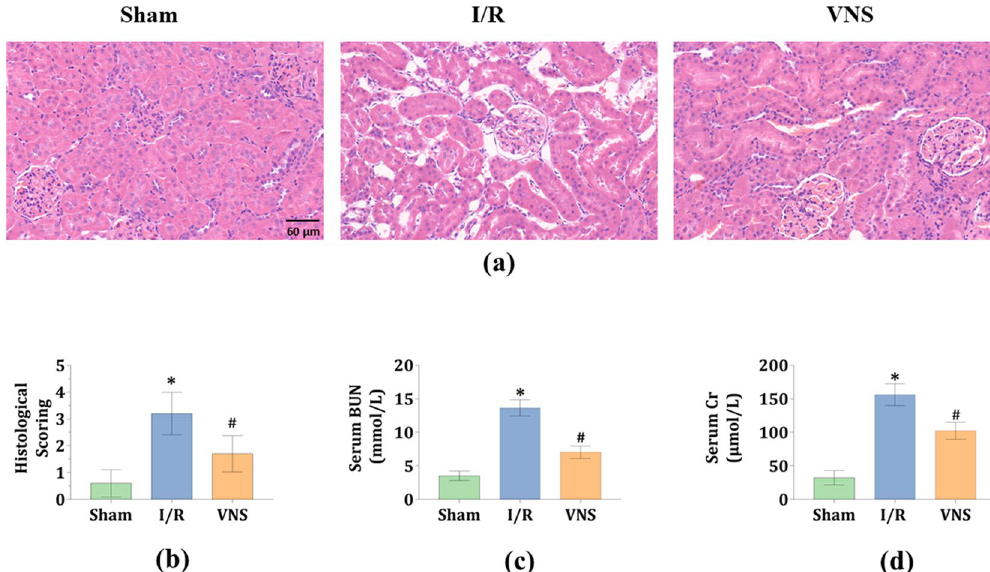
Figure 1. VNS alleviates kidney injury. ( a ) Representative H&E staining images of kidney tissues in the three groups are shown. ( b ) Kidney histological scores are shown. Levels of serum ( c ) BUN and ( d ) Cr are presented. *p < 0.05 vs. the Sham group; # p < 0.05 vs. the I/R group. H&E hematoxylin and eosin, BUN Blood urea nitrogen, Cr creatinine. Light microscope (× 400